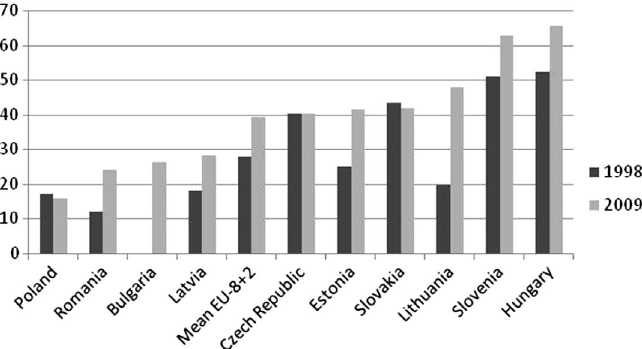
Fig. 4. Ratio of non-contributory social spending in the EU-8+2 to the